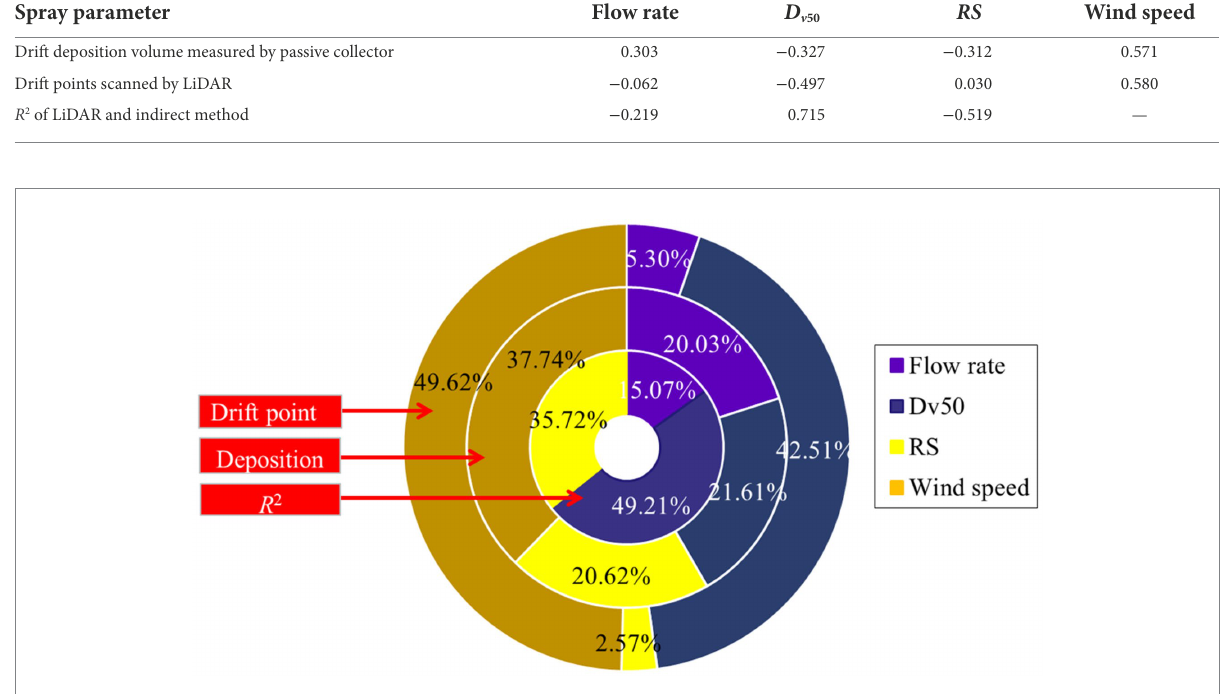
FIGURE 8 Influence weights of spray parameters on drift